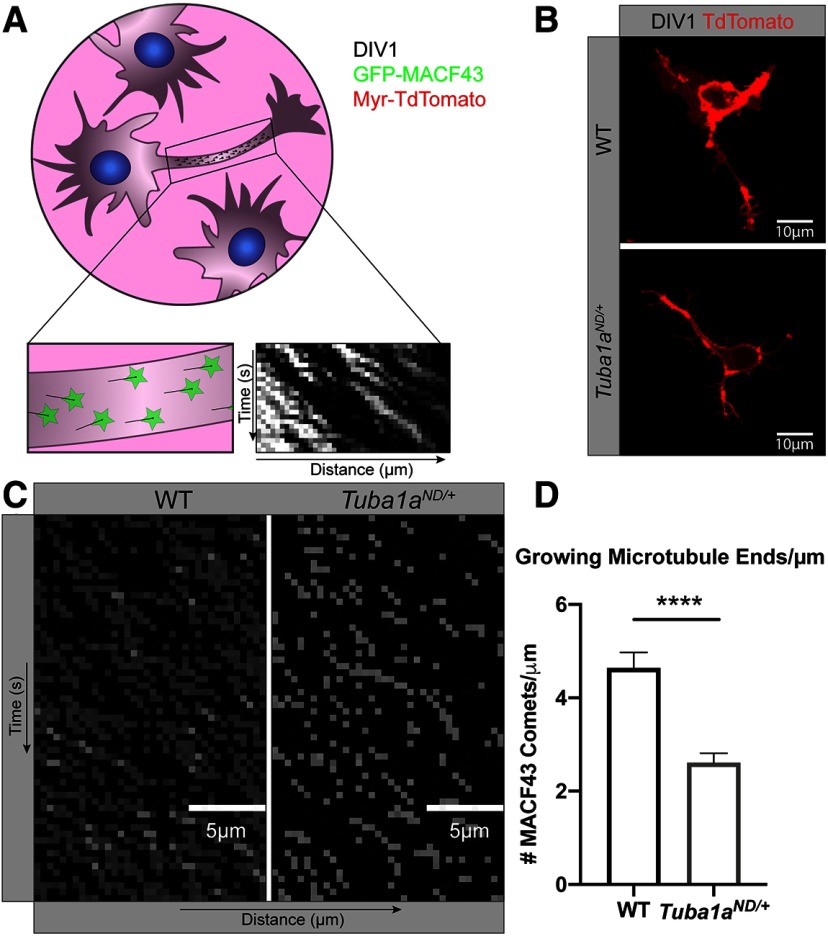
Reduced TUBA1A function results in fewer microtubule tracks in neurites. A, Schematic of experimental design, illustrating microtubule plus-end tracker, GFP-MACF43, puncta analysis and kymograph generation. B, Representative images of day in vitro (DIV) 1 wild-type (WT) and Tuba1aND/+neurons, visualized using a membrane-bound Myr-TdTomato. Scale bars: 10 μm. C, Representative kymograph plots generated from GFP-MACF43 images in wild-type (left) and Tuba1aND/+(right) neurons. Scale bars: 5 μm. D, Bar graph representing the number of GFP-MACF43 puncta per μm of neurite in DIV1 wild-type and Tuba1aND/+cortical neurons. Bars illustrate mean density of GFP-MACF43 puncta per kymograph and error bars indicate SEM (n = 24 neurons, p < 0.0001). Statistical differences between groups were assessed by t test. ****p < 0.0001.